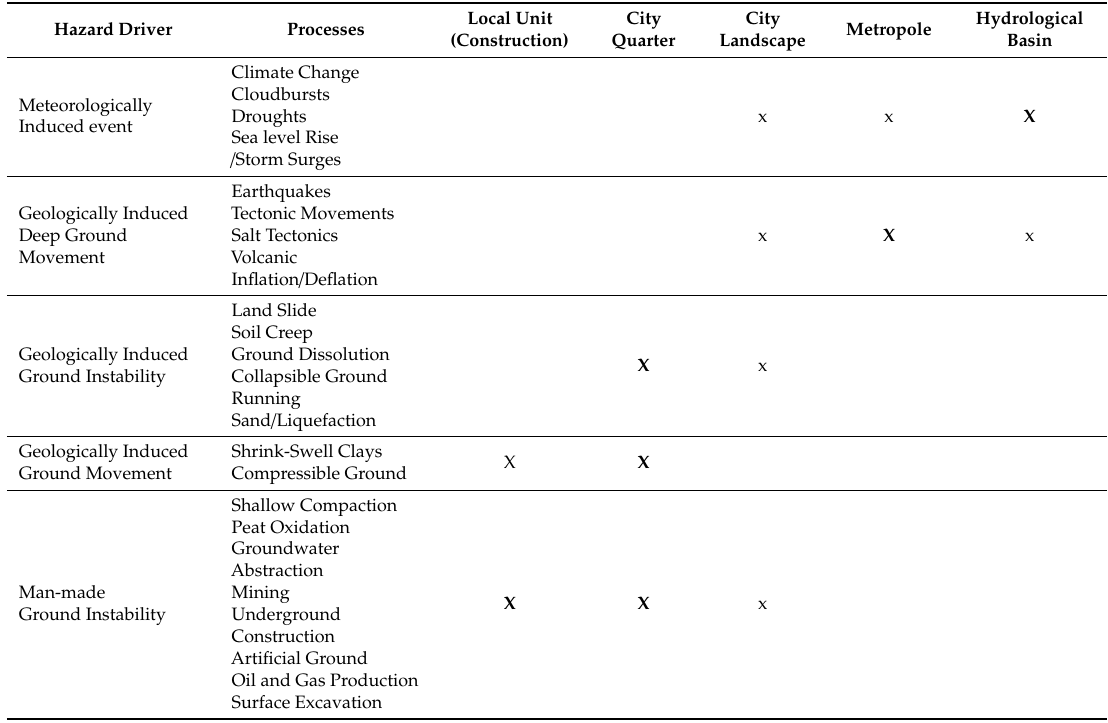
Table 1. Estimated spatial extension of urban processes related to climatic, geological, and man-made hazards (capital bold letters indicate the main spatial regime). Modified after The PanGeoProject [16]. Hydrological Local Unit City City Metropole Hazard Driver Processes Basin (Construction) Quarter Landscape Climate Change